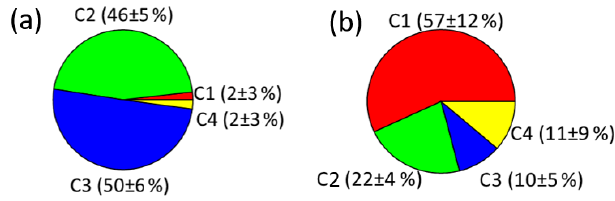
Figure 4. A comparison of relative contributions of the four compo- nents identified by PARAFAC model analysis to total fluorescence for summer (a) and winter (b)